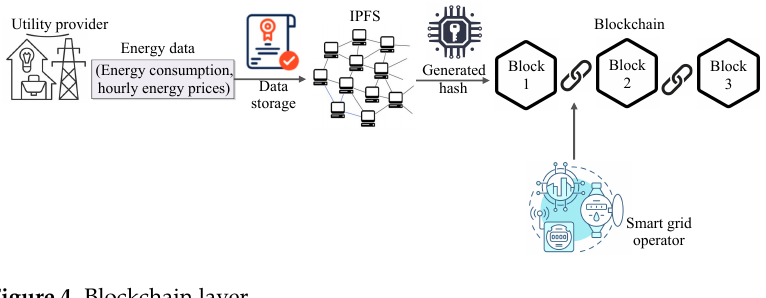
Figure 4. Blockchain layer.